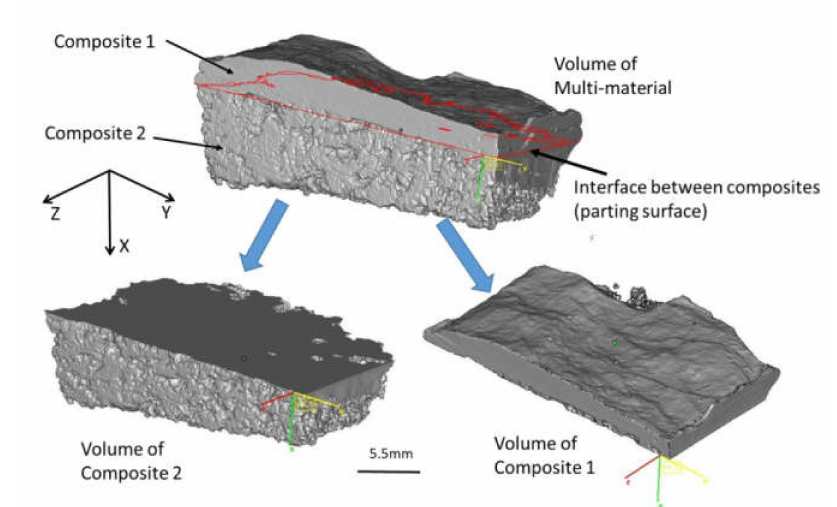
Figure 10. Splitting procedure of the multi-material volume into constituent materials volumes for sample S1. A local coordinate system is represented within the figure.